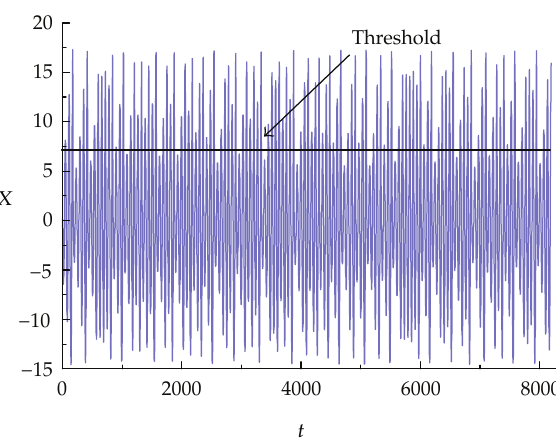
Figure 4: X -component fluctuations of a chaotic solution of the R ¨ ossler system (cid:2) 3.3 (cid:3) (cid:2) a (cid:7) 0 . 15 , b (cid:7) 0 . 20 , c (cid:7) 10 . 0 (cid:3) .